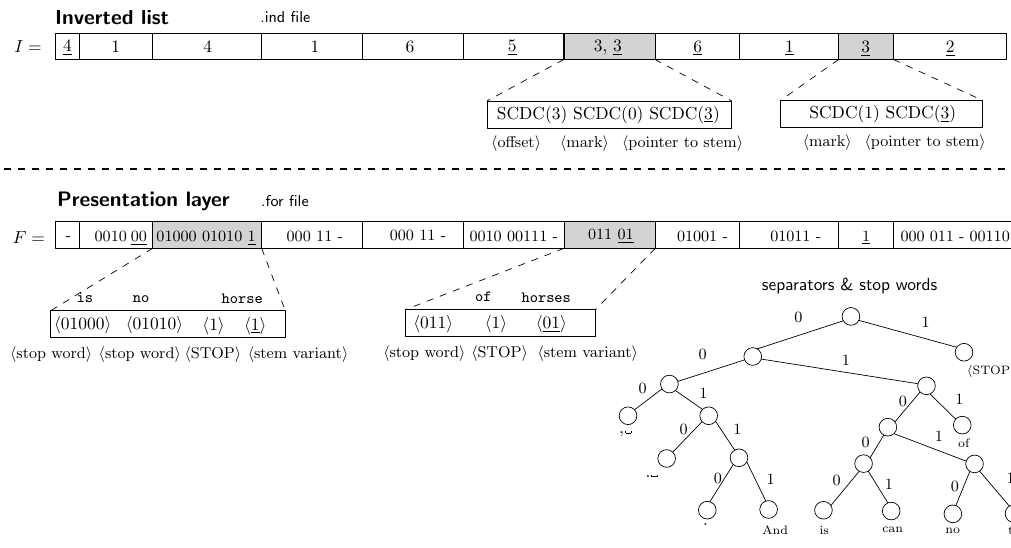
Figure 2. PISI data structure: Detail of inverted list and presentation